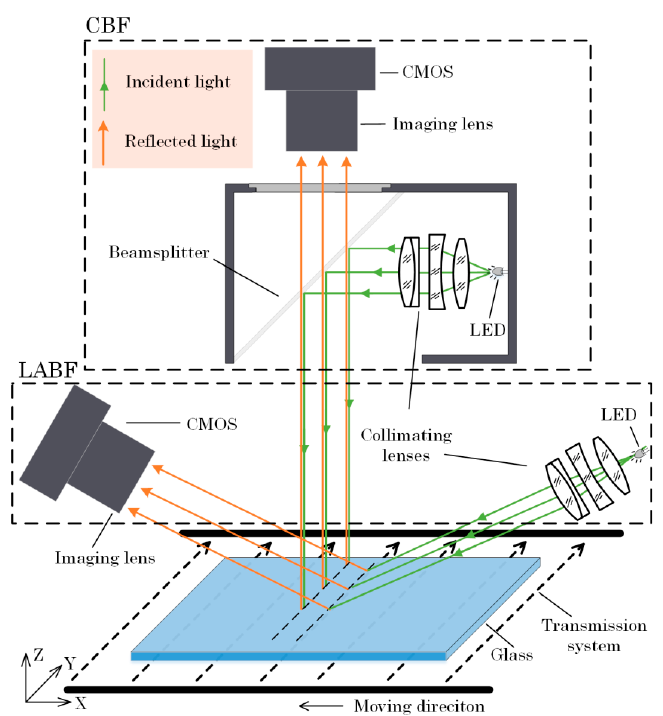
Figure 1. Sketch of the coaxial bright-field (CBF) imaging system and low-angle bright-field (LABF) imaging system, composed of an light emitting diode(LED) light source, collimating lenses, beam-splitter, imaging lens, and CMOS.